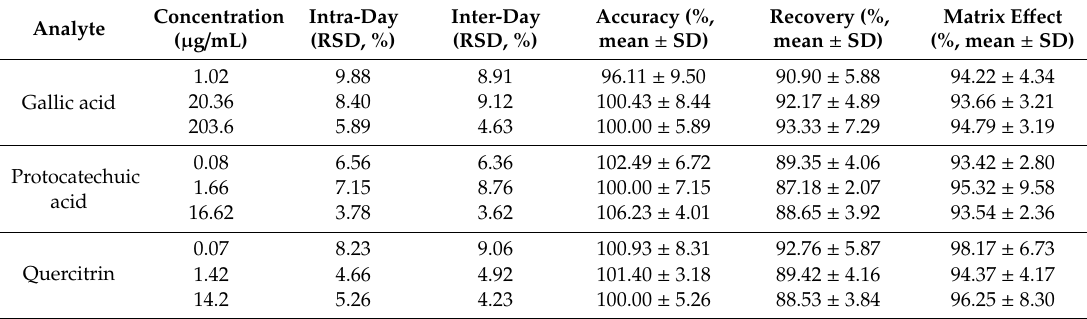
Table 2. Summary of accuracy, precision, extraction recovery, and matrix e ff ect data of GA, PCA, and QR in rat plasma ( n = 5).